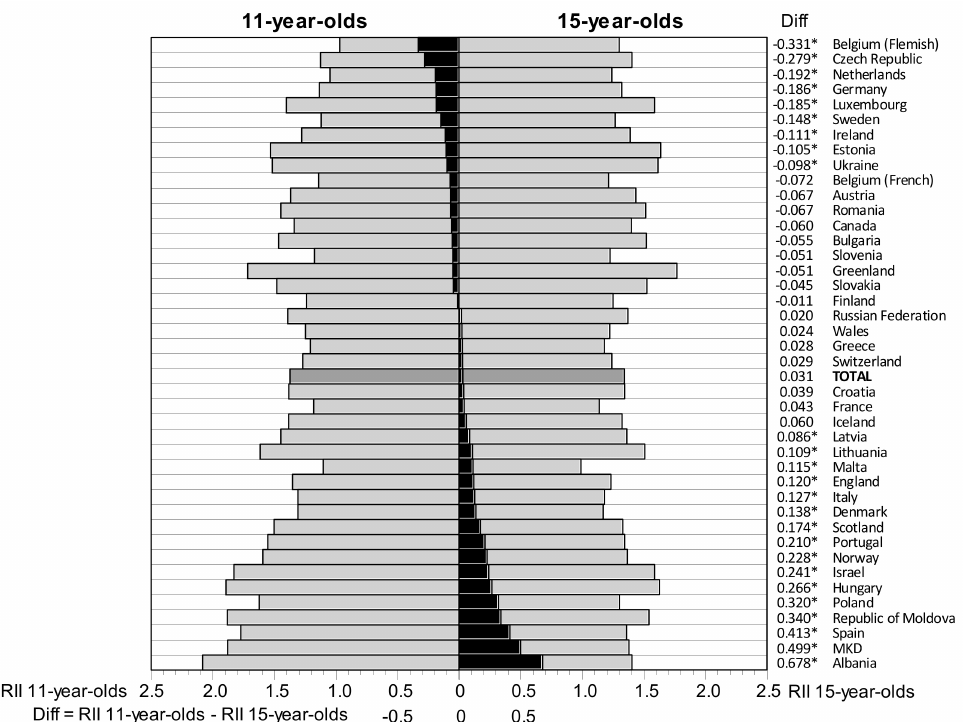
Figure 2. Relative Indices of Inequality (RII) in life satisfaction among 11-year-olds and 15-year-olds, and their differences (black bars) in HBSC countries. * p < 0.05 that difference = 0. For Slovakia, 11-year-olds were replaced by